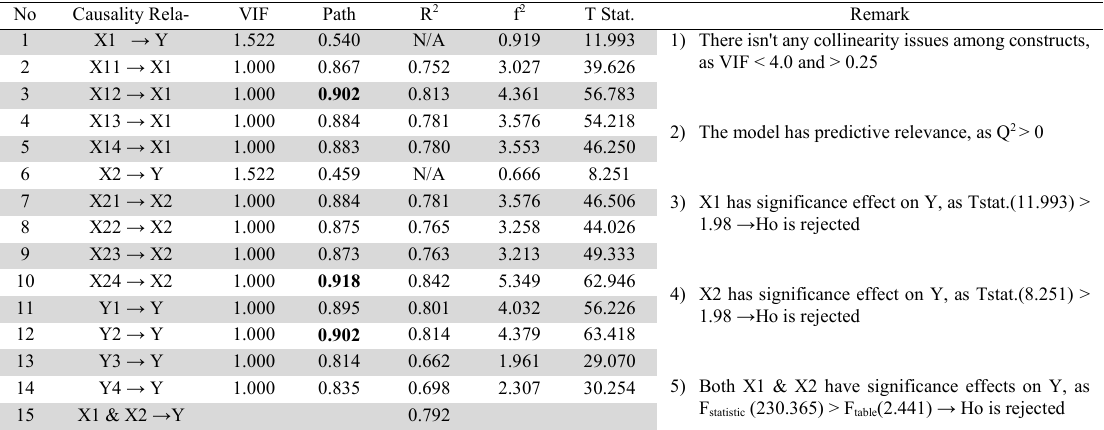
The results of Inner model